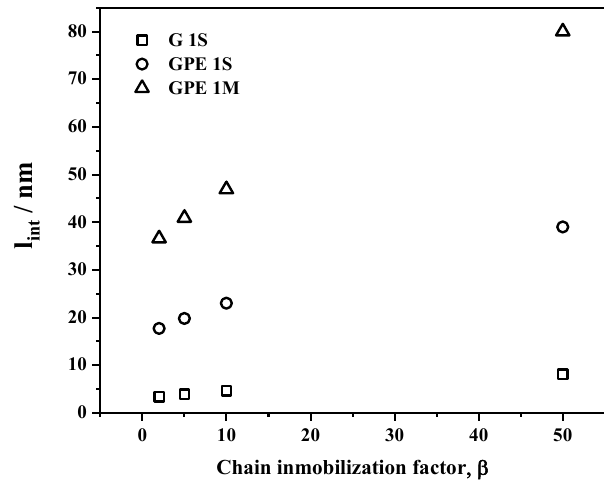
Figure 11. Plot comparing the extent of the interface for representative samples, and its Figure11. Plot comparingthe extentof the interfacefor representative samples, and itsdependence on β dependence on  .